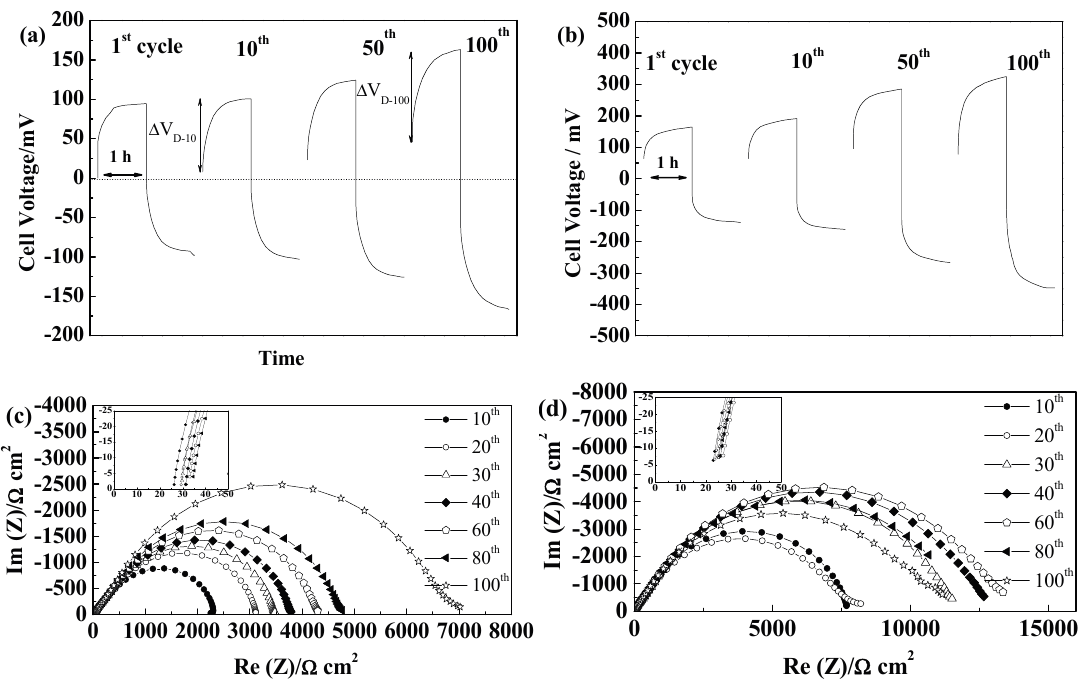
TFSI cell; ( b ) Voltage profile of a 14 TFSI cell; 14 TFSI 12O1